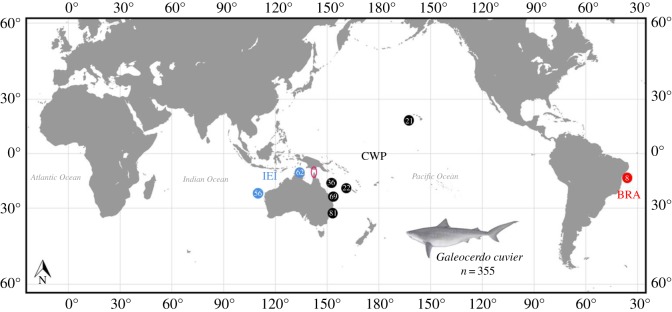
Sampling locations and number of G. cuvier tissue samples obtained from the Indo-East Indian (IEI, blue), the Central-West Pacific (CWP, black) and the Atlantic Ocean (BRA, red). Pink open circle denotes the Torres Strait land bridge.